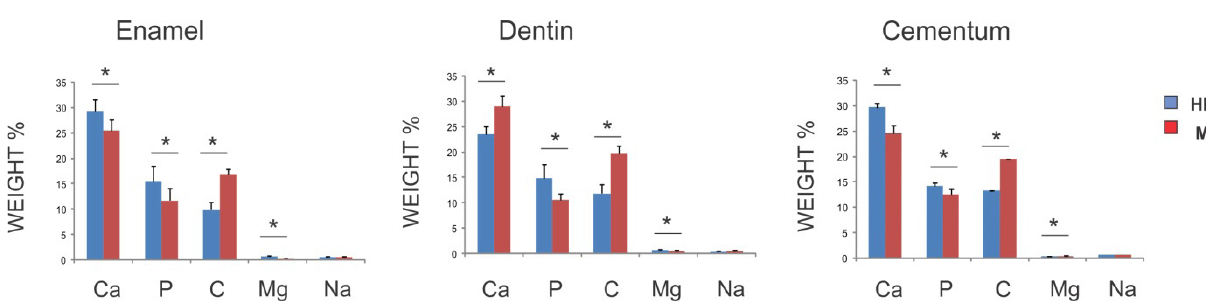
Fig. 1. Distibution ofbasic chemical elements in healthy and mesiodens enamel, dentine and cementum in weight percentage. HE- healthy teeth; M-mesiodens;